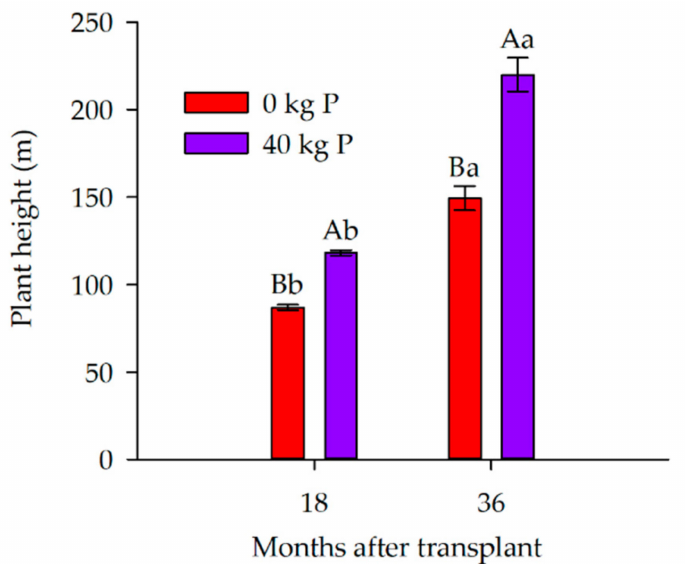
Figure 4. Height of H. heptaphyllus plants (at 18 and 36 months after transplant) subjected to ap- plications of 0 and 40 kg P ha − 1 . Uppercase letters compare P rate considering the same time, while lowercase letters compare times based on the Tukey test ( p < 0.05), since the interaction was significant at 5% based on two-way analysis of variance. Vertical bars represent the standard error of three